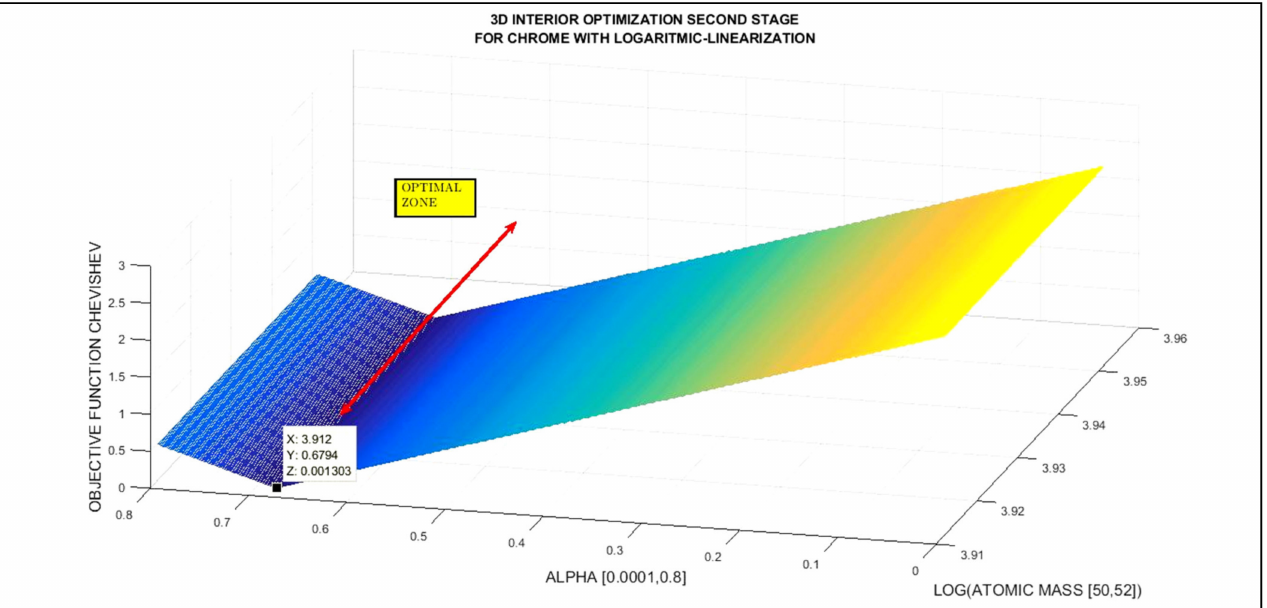
Figure 6. Chrome second stage of 3D interior optimization. Optimal zone is accurate and OF magnitude is about 1 × 10 − 3 . This value validates the chrome GA results. Subroutine for image processing is different from the first-stage 3D interior optimization charts. Image processing method 2.